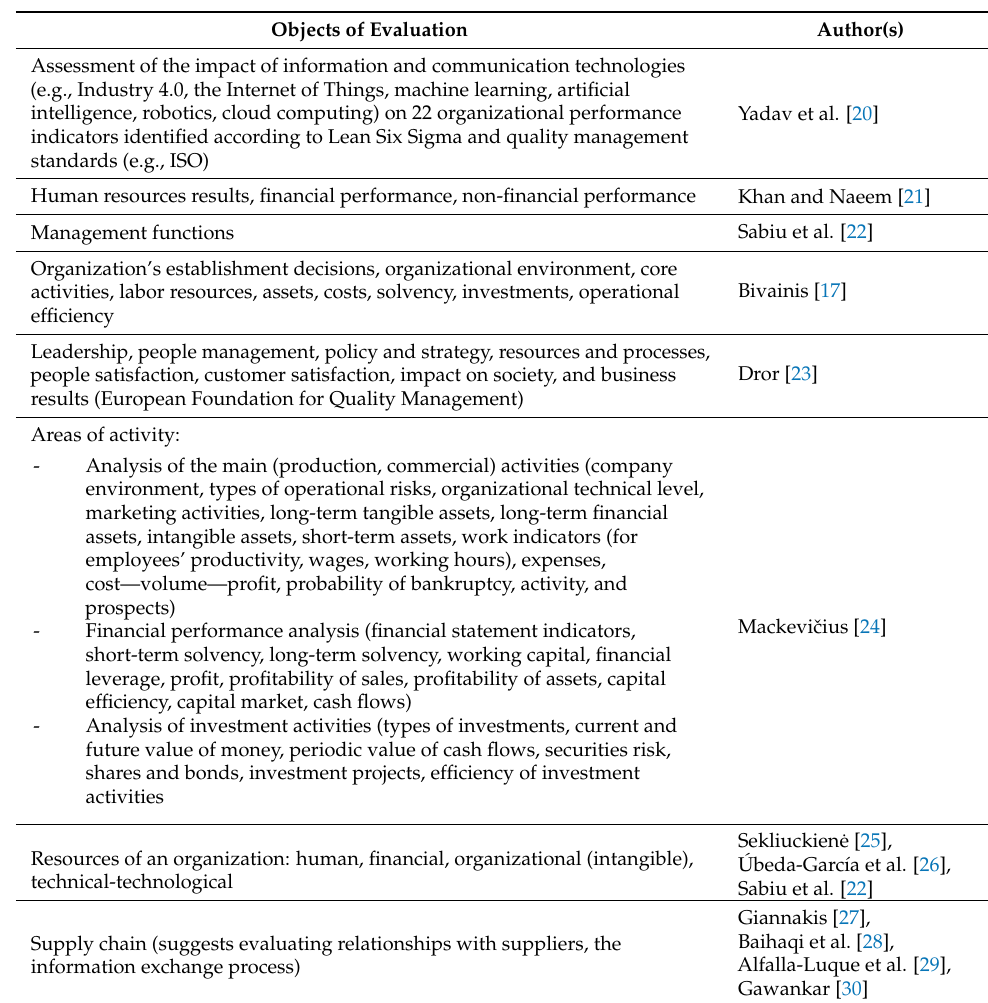
Table 1. The variety of methods for evaluating an organization’s performance according to the objects of